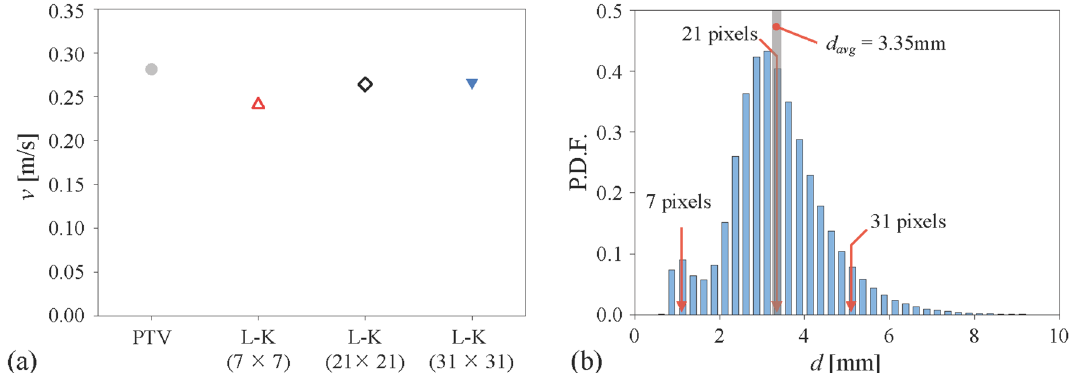
Figure 3. Effect of window size on the optical flow measurement: ( a ) averaged vertical velocity (filled circle, PTV; open triangle, Lukas-Kanade method with the window size of 7 × 7; open diamond, 21 × 21; inverted filled triangle, 31 × 31 pixels); ( b ) probability density function of measured bubble size (solid lines denote the tested window sizes). Here, the measurements were done for the dilute bubble plume (Fig. 2b) with the mean bubble diameter of 3.4 mm and void fraction of